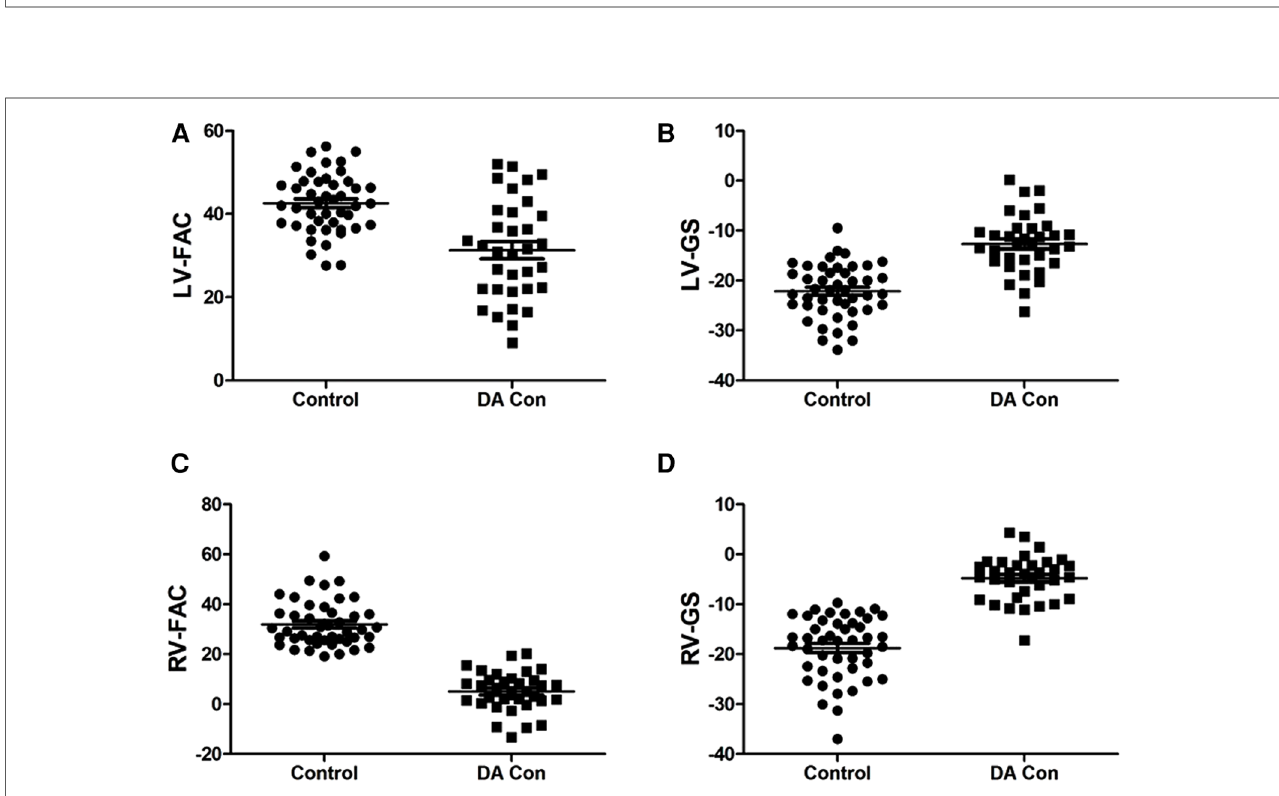
FIGURE 6 Scatter plot of left ventricle (LV)-fractional area change (FAC), LV-global strain (GS), right ventricle (RV)-FAC and RV-GS in the fetuses with mild to moderate and moderate to severe ductus arteriosus constriction (DA Con). ( A ) LV-FAC values in the control group and DA Con group. ( B ) LV-FS values in the control group and DA Con group. ( C ) RV-FAC values in the control group and DA Con group. ( D ) RV-GS values in the control group and DA Con